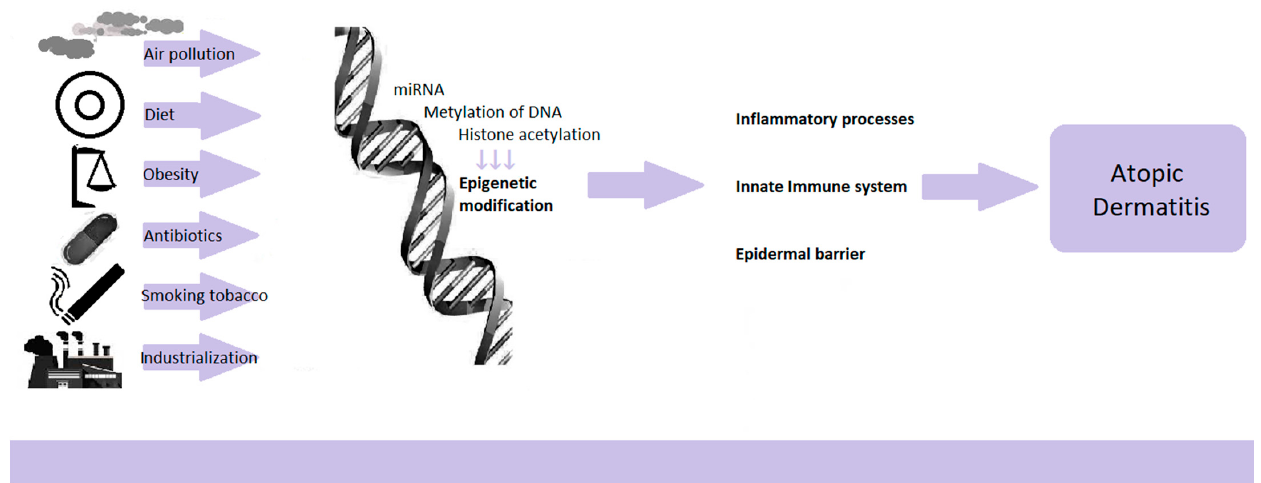
Figure 1. Epigenetic regulations dependent on environmental factors.